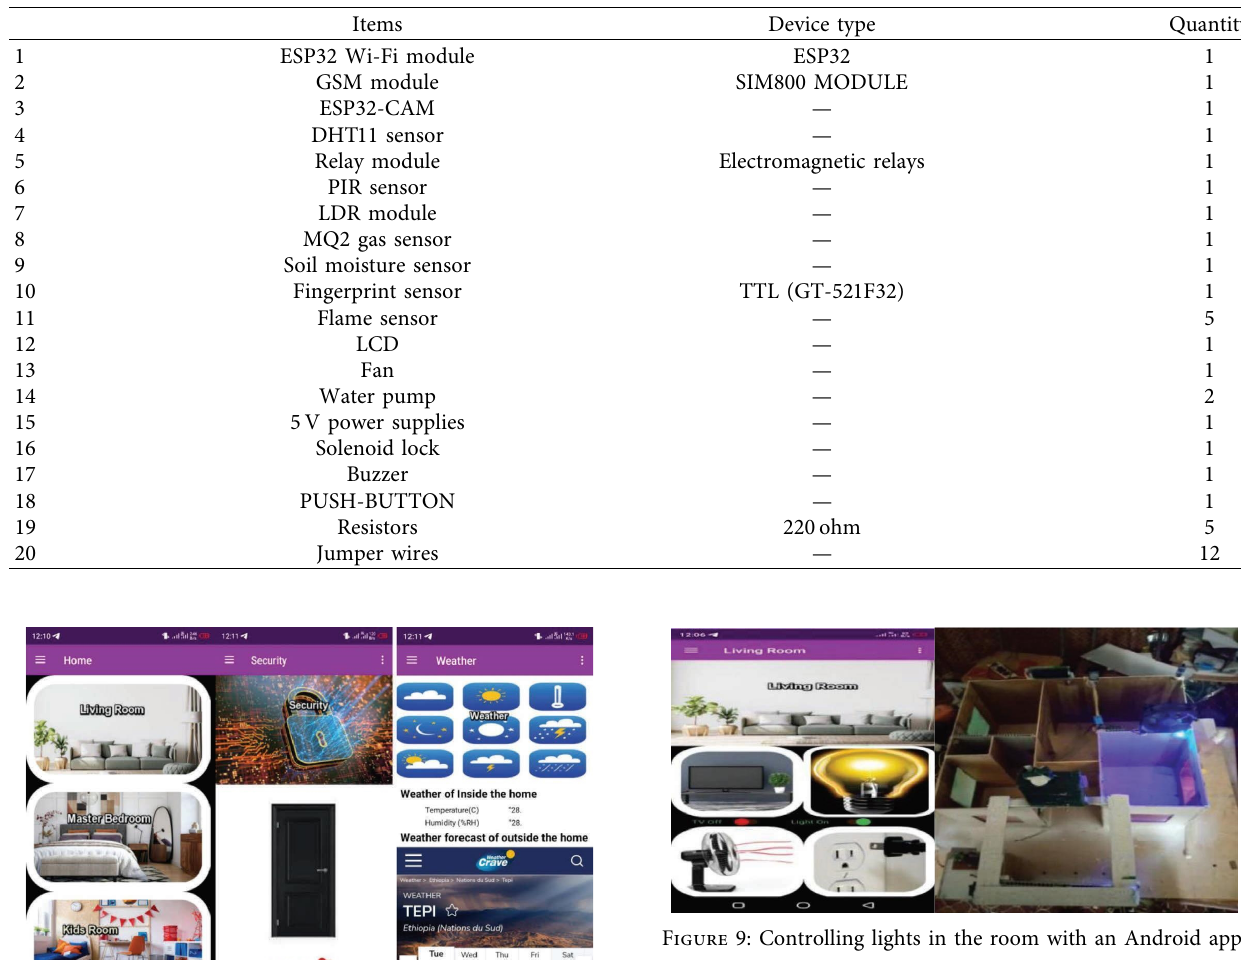
Table 1: Material used.